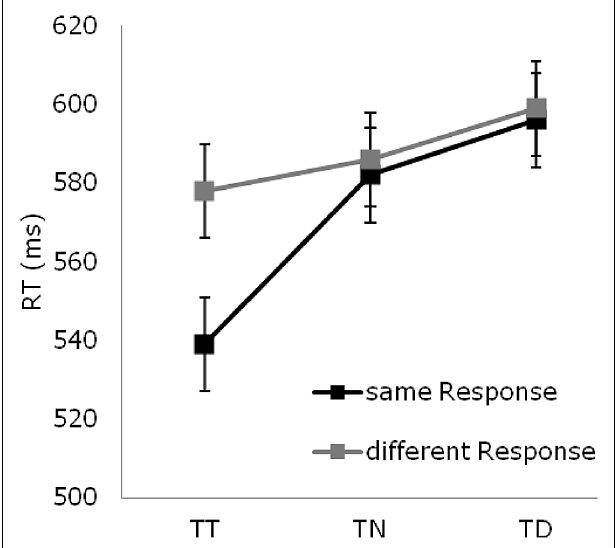
FIGURE 2 | Reaction time data: mean reaction times (in msec) for targets occurring at previous target (TT), neutral (TN), and distractor (TD) locations, separately for same- (black lines) and different- (gray lines) response trials. Error bars represent standard error of the mean.